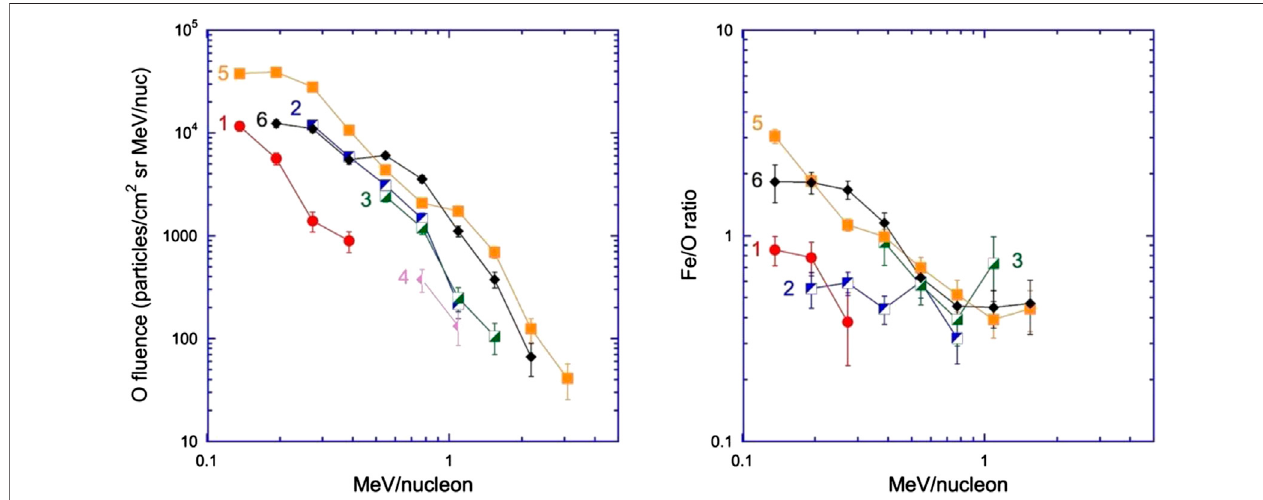
FIGURE5| Left: oxygenenergyspectraofthesix 3 He-richeventslistedin Table1 ;theenergyrangescoveredareaffectedbythedropoutcutoff(seetext)inevents 1-4. Right: Fe/O ratio in each event (except 4) showing wide variation at low energies.